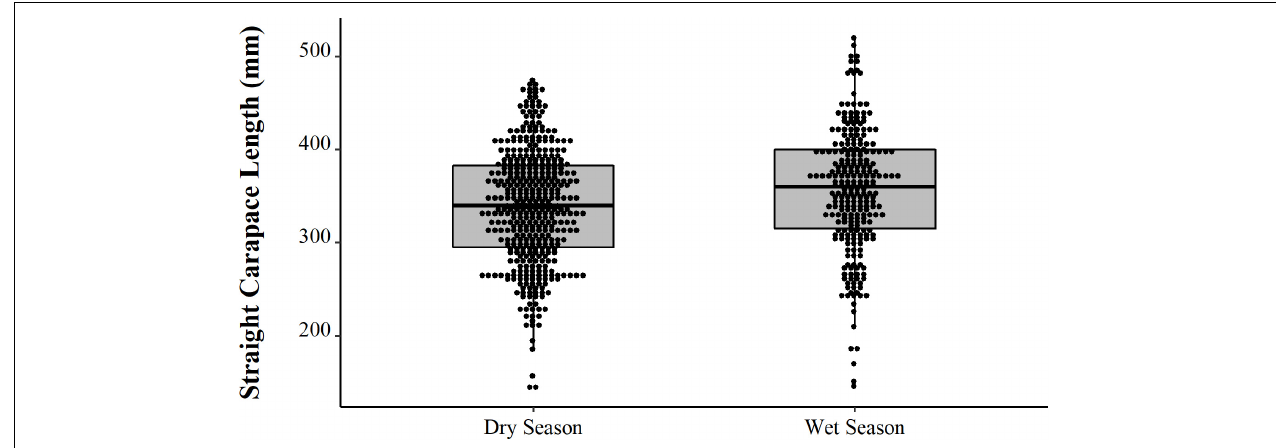
FIGURE 7 | Distributions (points) and descriptive statistics (boxplot) of body size (SCL, mm) and Big-headed ( Peltocephalus dumerilianus ) from the Negro River, Amazonas, obtained between 1997 and 2019, captured in the dry and rainy